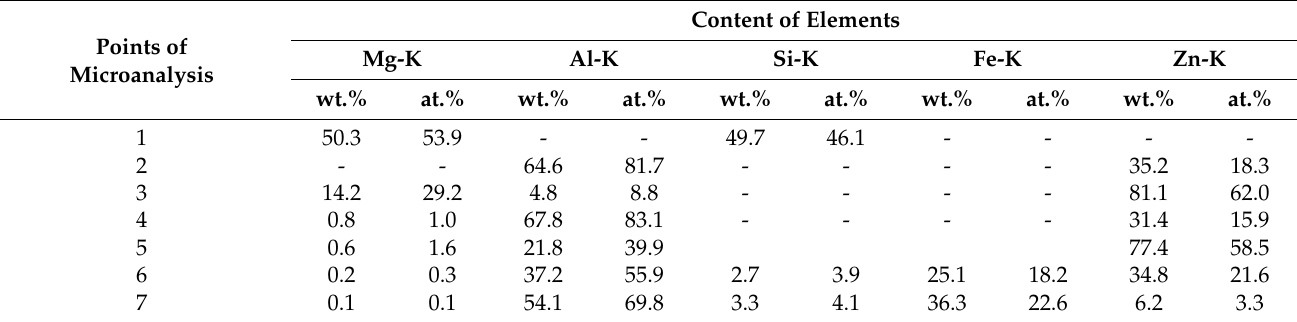
Figure 5. SEM microstructure of the coating obtained in the ZnAl23Mg6Si0.4 bath. Table 6. Chemical composition in the micro-areas (EDS) of the coating obtained in the ZnAl23Mg6Si0.4 bath (analysis points as shown in Figure 5).